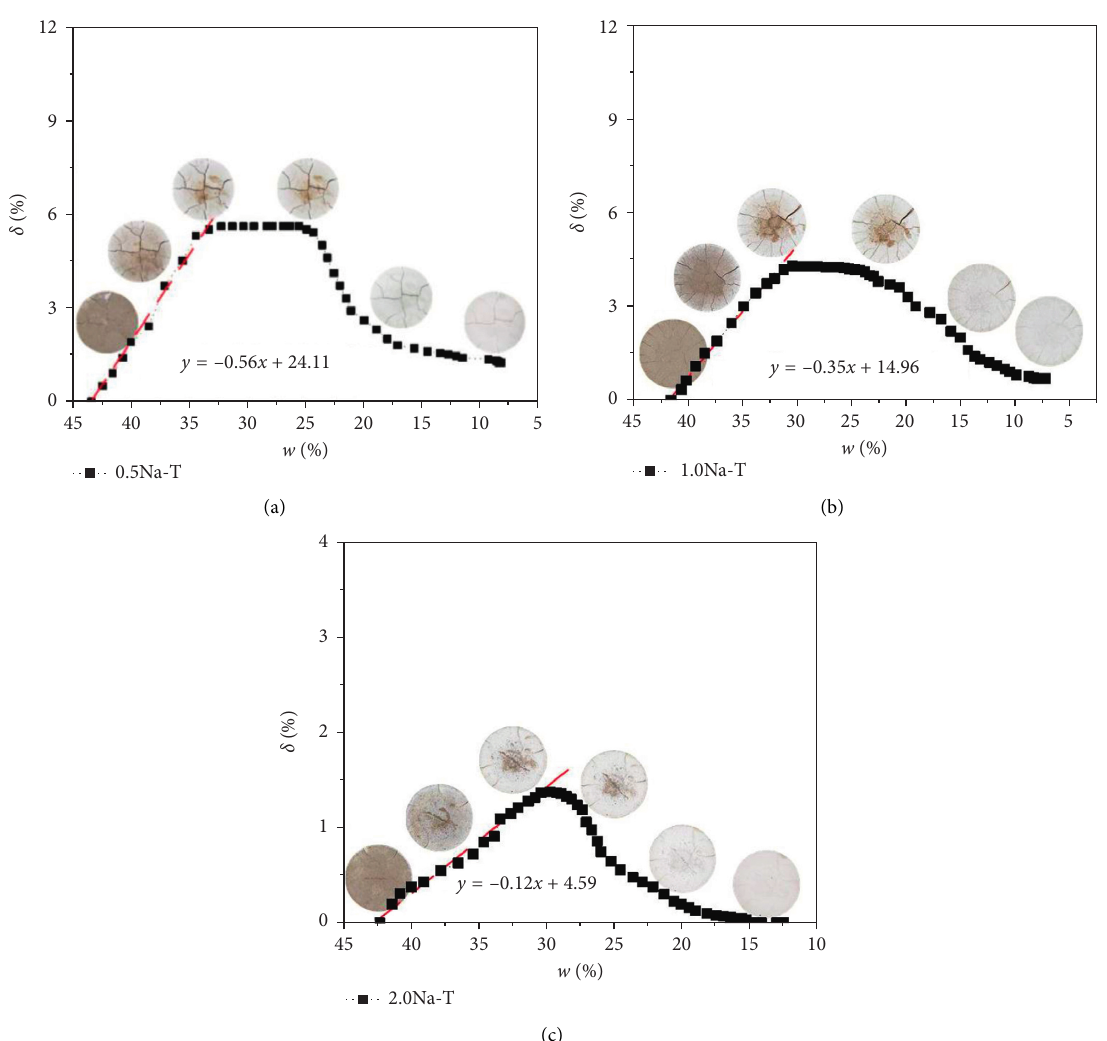
Figure 8: Variation of surface crack ratio ( δ ) with water content ( ω ) for specimens saturated with NaCl